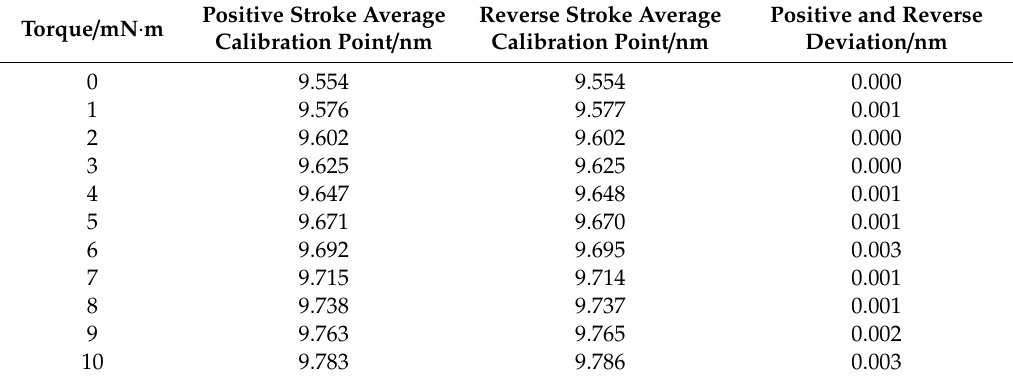
Table 3. The average calibration points and deviation values of torque